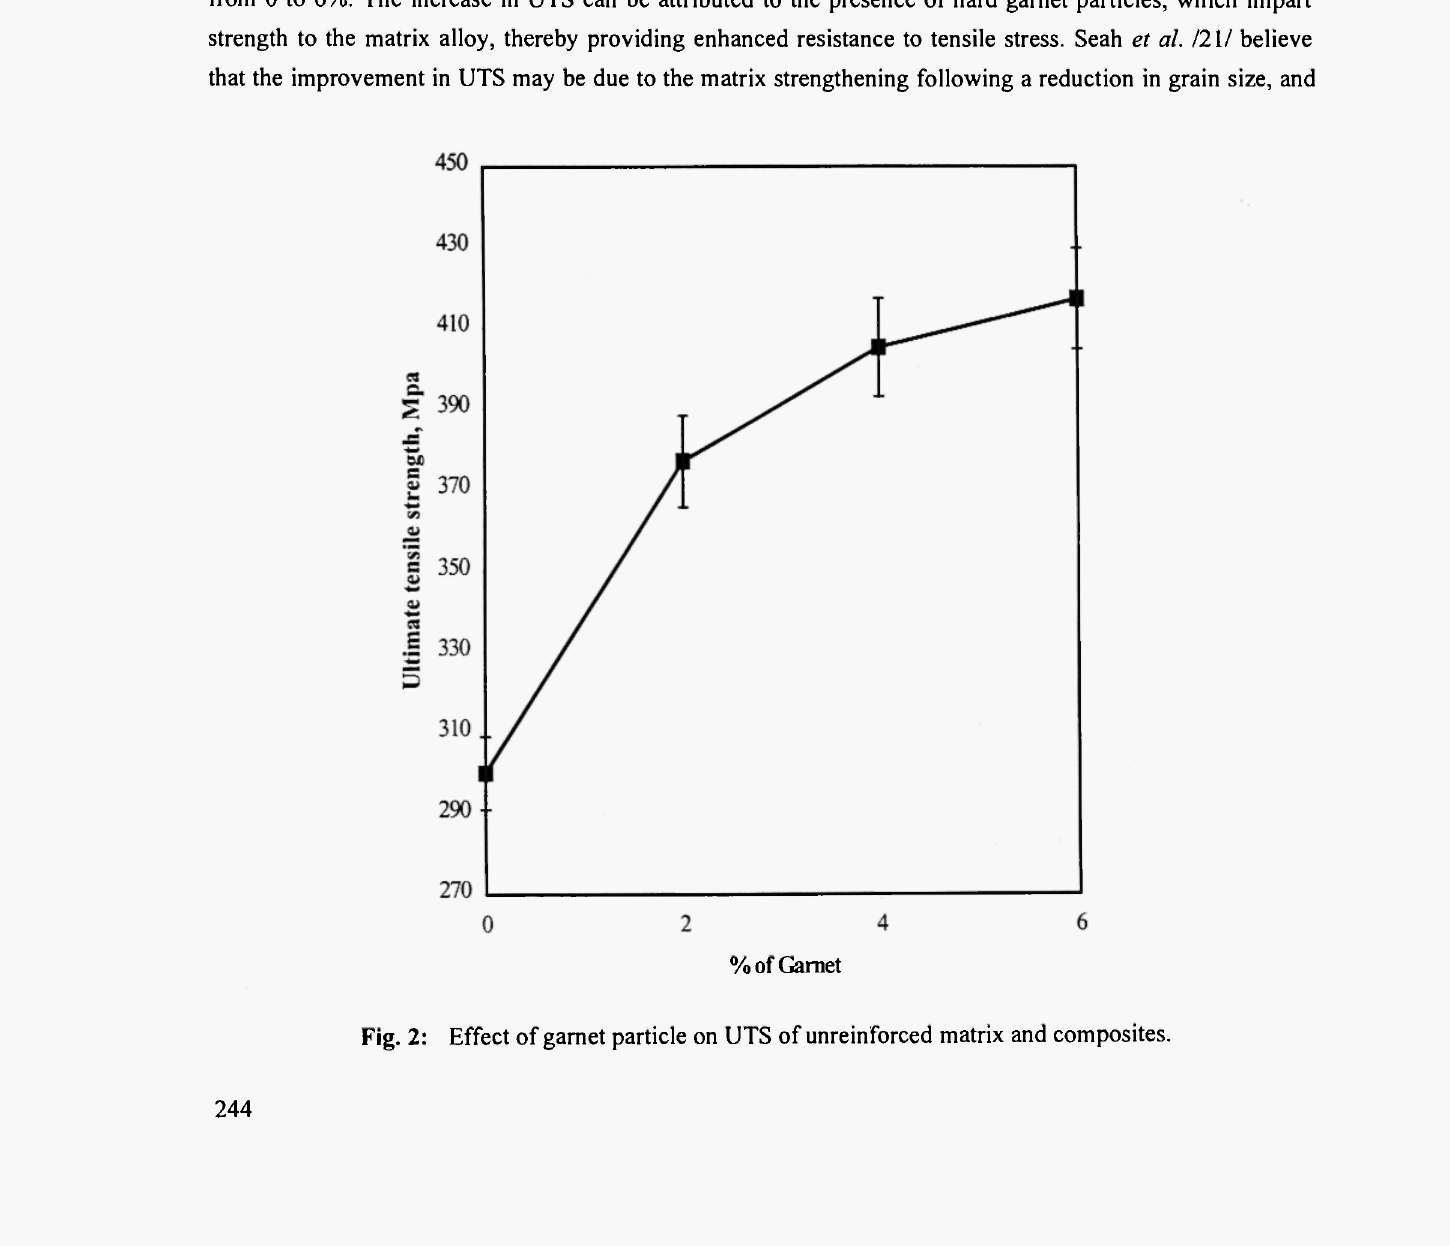
Fig. 2: Effect of garnet particle on UTS of unreinforced matrix and